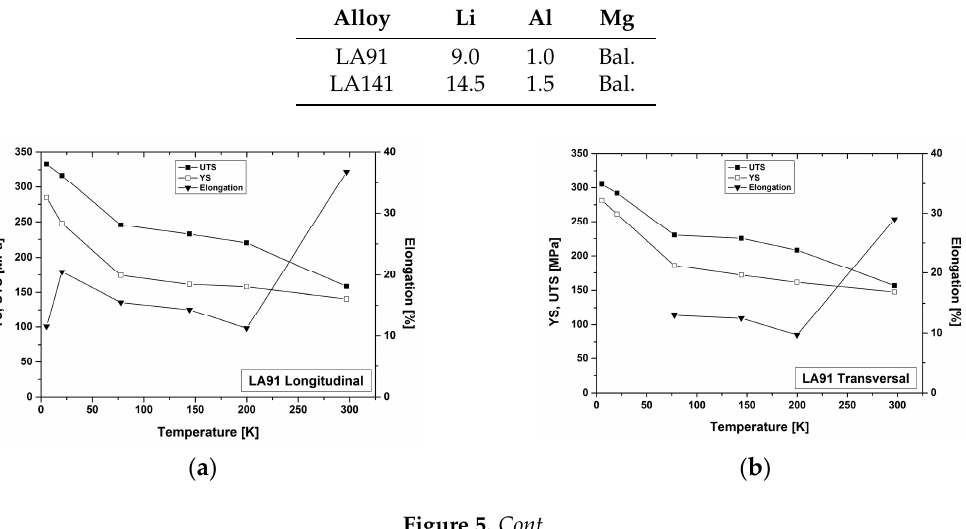
Table 4. Composition of magnesium ‐ lithium alloys.